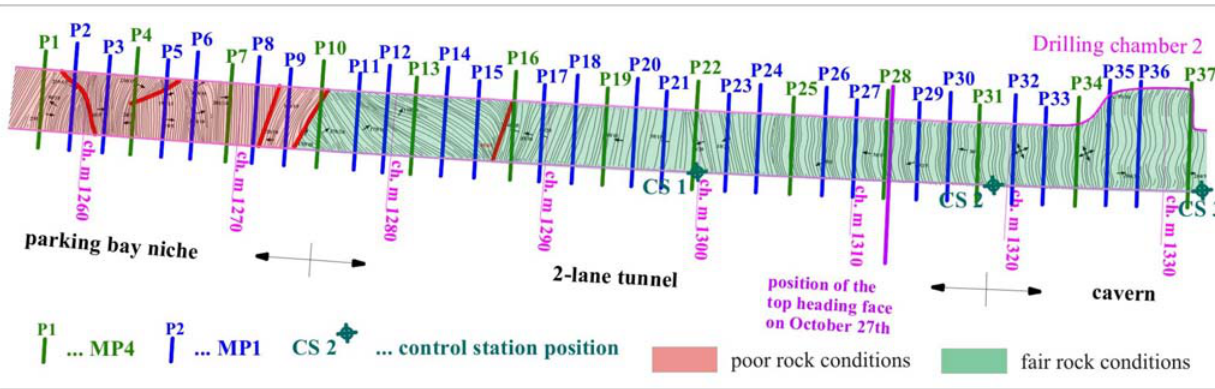
Figure 5. Disposition of the measuring cross sections and control station positions in the right tube of the exploratory tunnel with lined geological